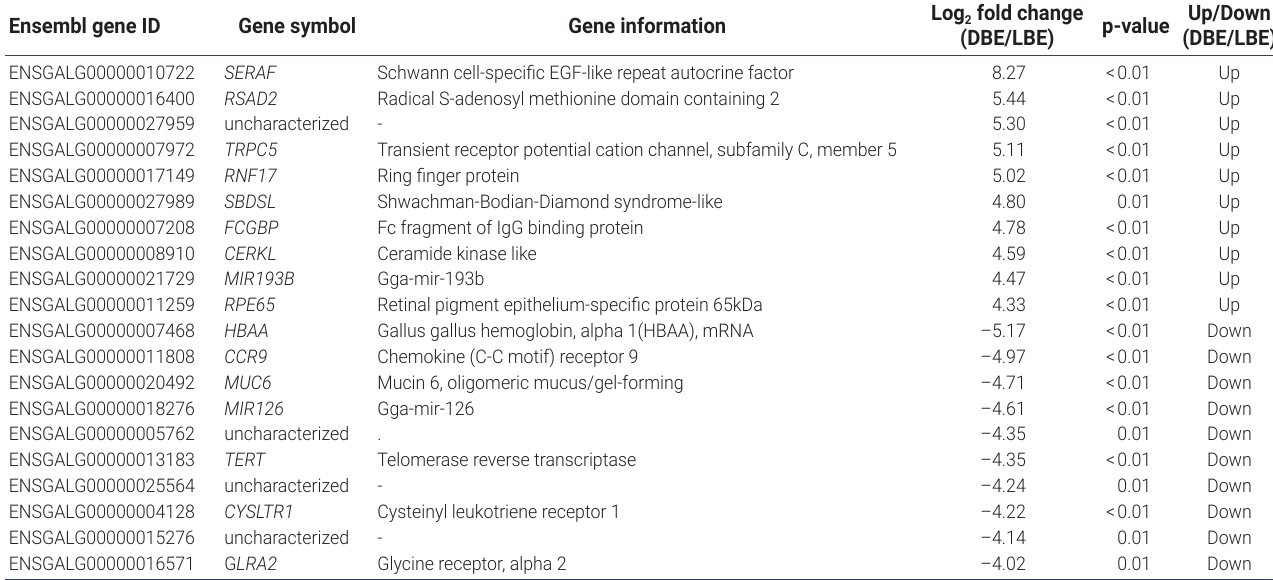
Table 3. Detailed information of the top 20 most differentially expressed genes responsible for different brown eggshell